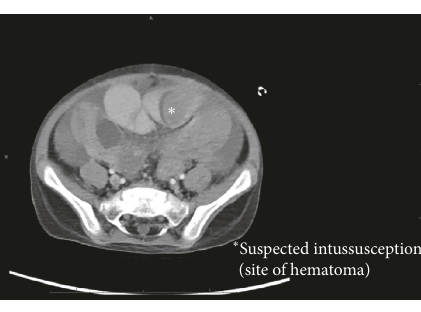
Figure 3: Axial CT.